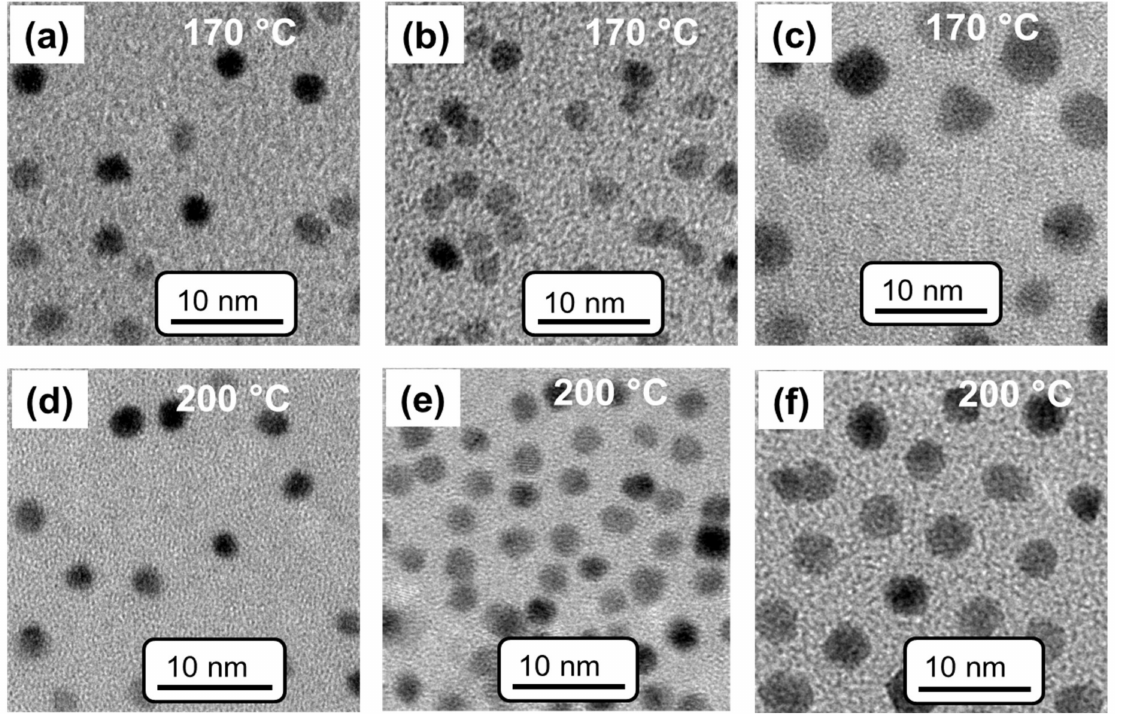
Figure 2. High magnification TEM images of M-PtNPs, D-PtNPs, and T-PtNPs: ( a – c ) at 170 ◦ C; ( d – f ) and at 200 ◦